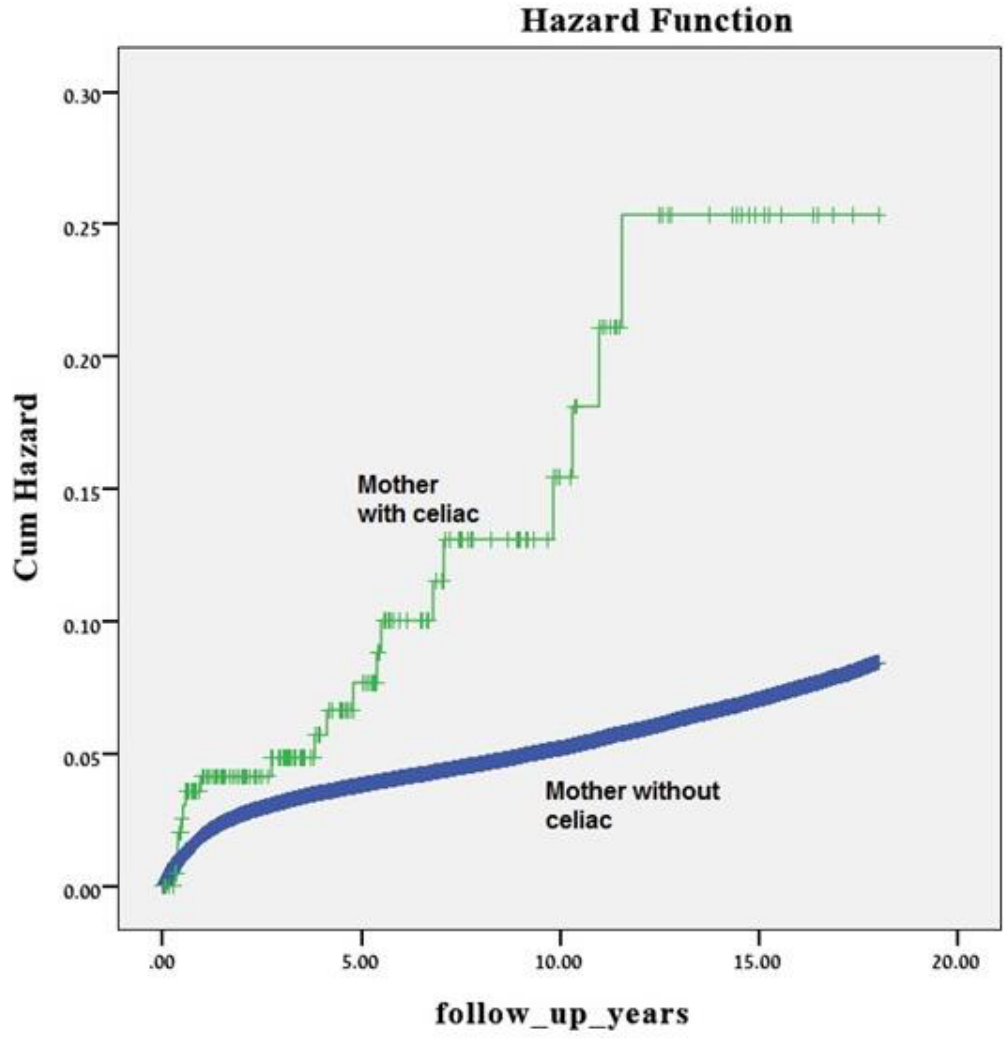
Figure 1. A Kaplan–Meier survival curve demonstrating the cumulative incidence of long-term gastrointestinal morbidity of the o ff spring according to maternal celiac (log rank, p < 0.001). Table 4. Proportional hazards model, to predict o ff spring long-term gastrointestinal morbidity. Adjusted